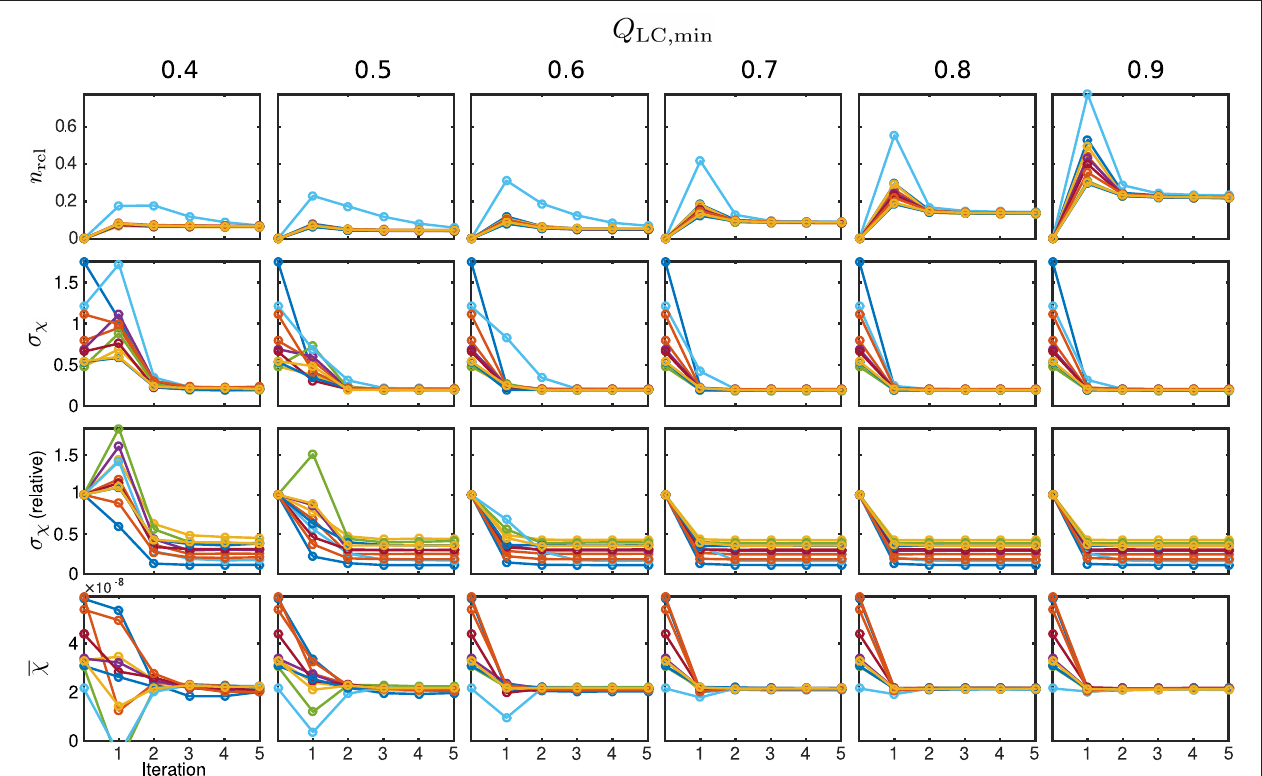
FIGURE 7 | Susceptibility and mask results for the simulation. One individual colour is used for each Monte Carlo case. From the top row to bottom: relative mask difference between true mask and phase masking result ( n rel ); heterogeneity (standard deviation, σ χ ) of susceptibility within reference area; heterogeneity normalised to conventional result without REFRASE; mean susceptibility value inside of reference area ( χ ). Each graph shows the conventional calculation without REFRASE as 0th point and the iteration result of REFRASE.